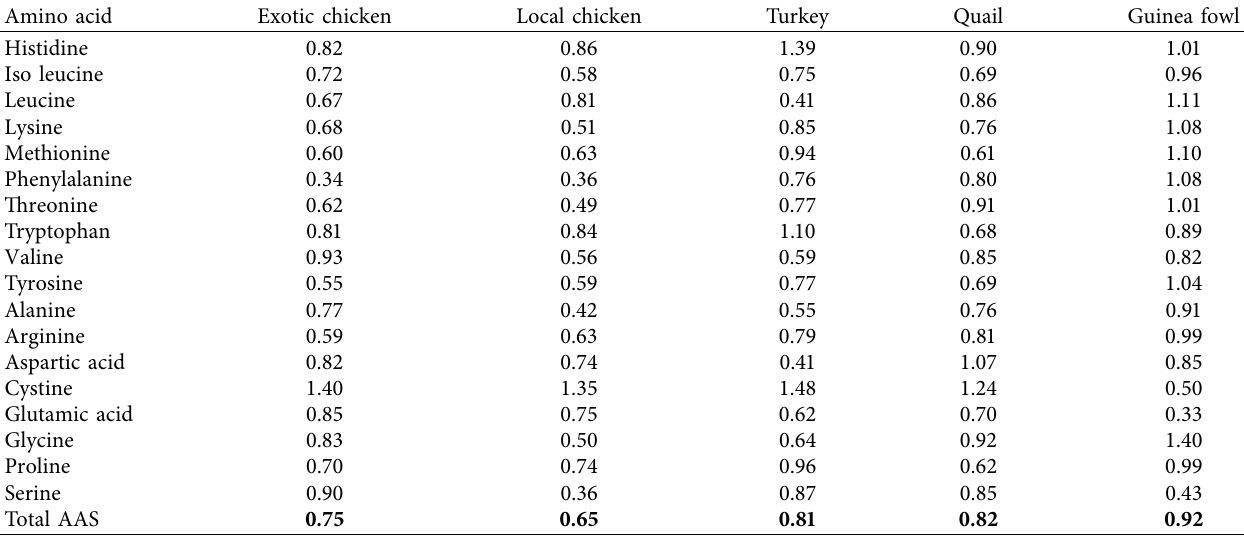
Table 4: Amino acid scores (AAS) of bird egg